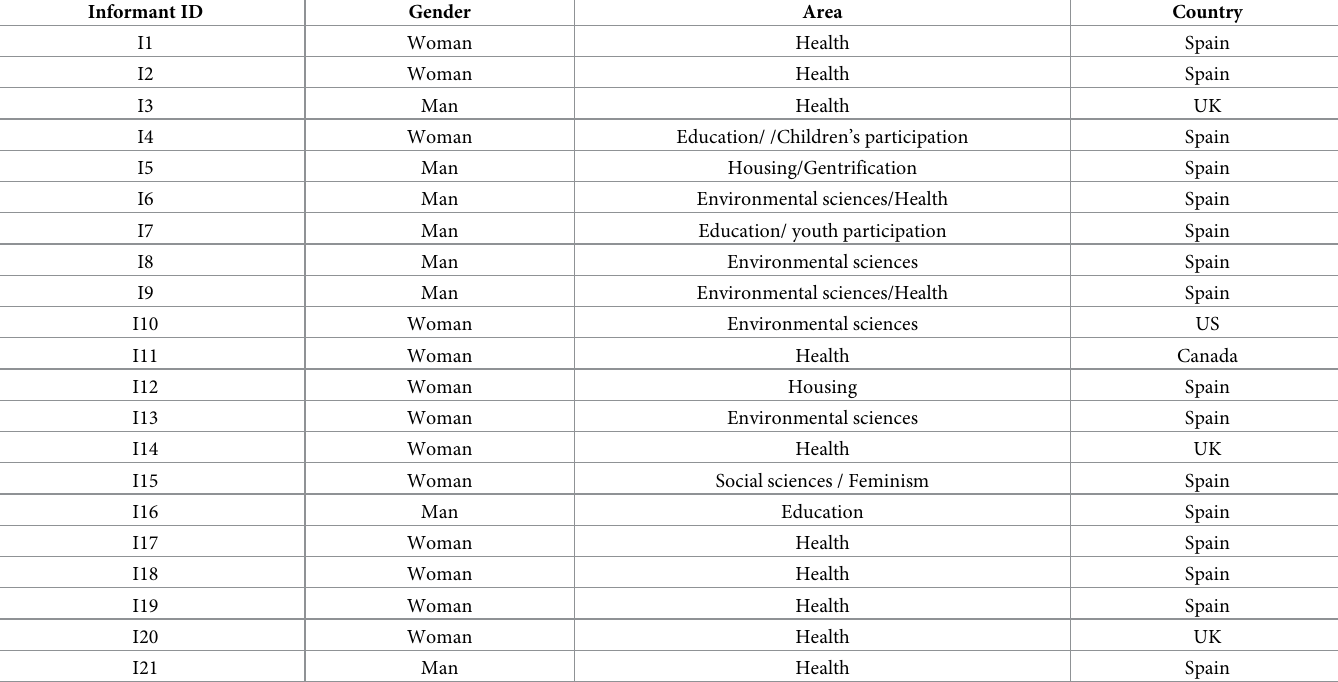
Table 1. Informants’ characteristics who have experience in PR or participatory processes and who were interviewed. Informant